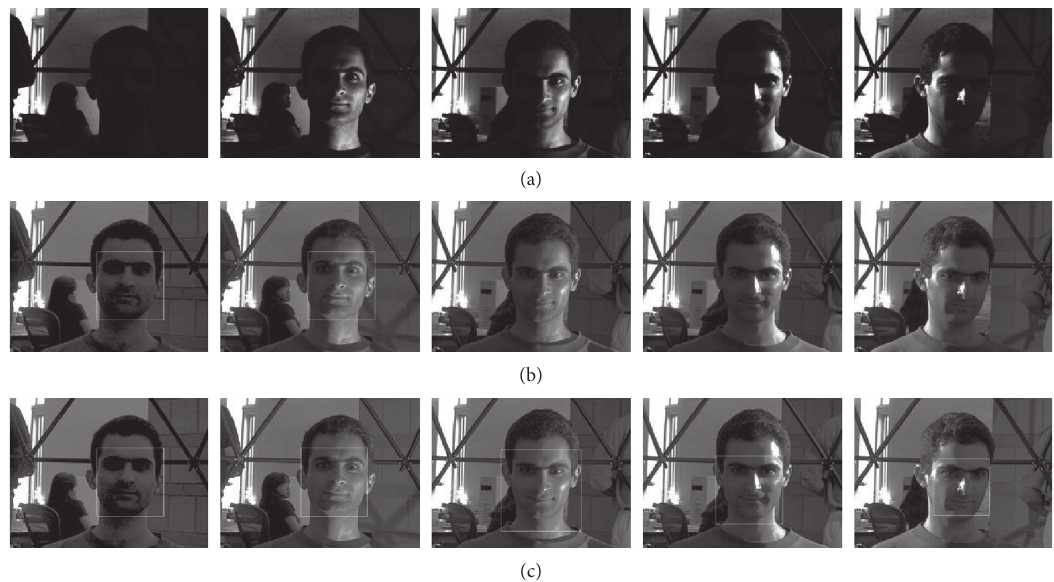
Figure 4: Comparison between [20] and ours. The improved algorithm we proposed performs better than that in [20]. (a) Original images that cannot detect face by HOG; (b) images processed in [20] and the detection result; (c) images processed by ours and the detection result.